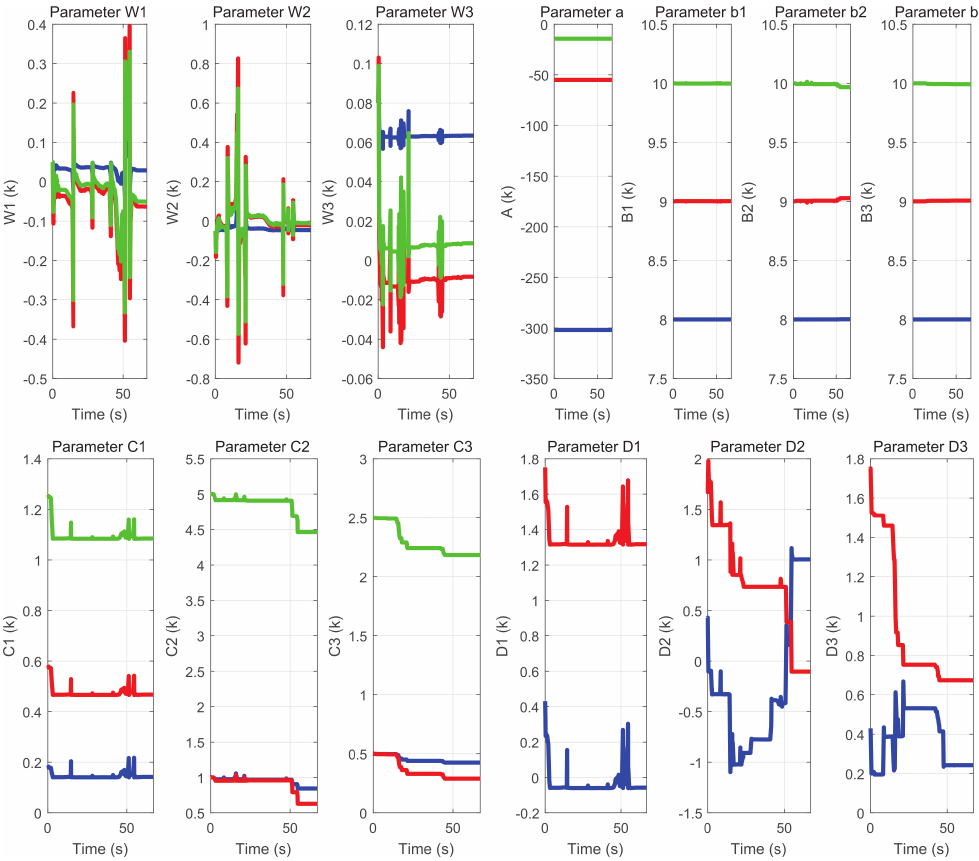
Figure 33. Behavior of neural network parameters used in the labyrinth of exercise